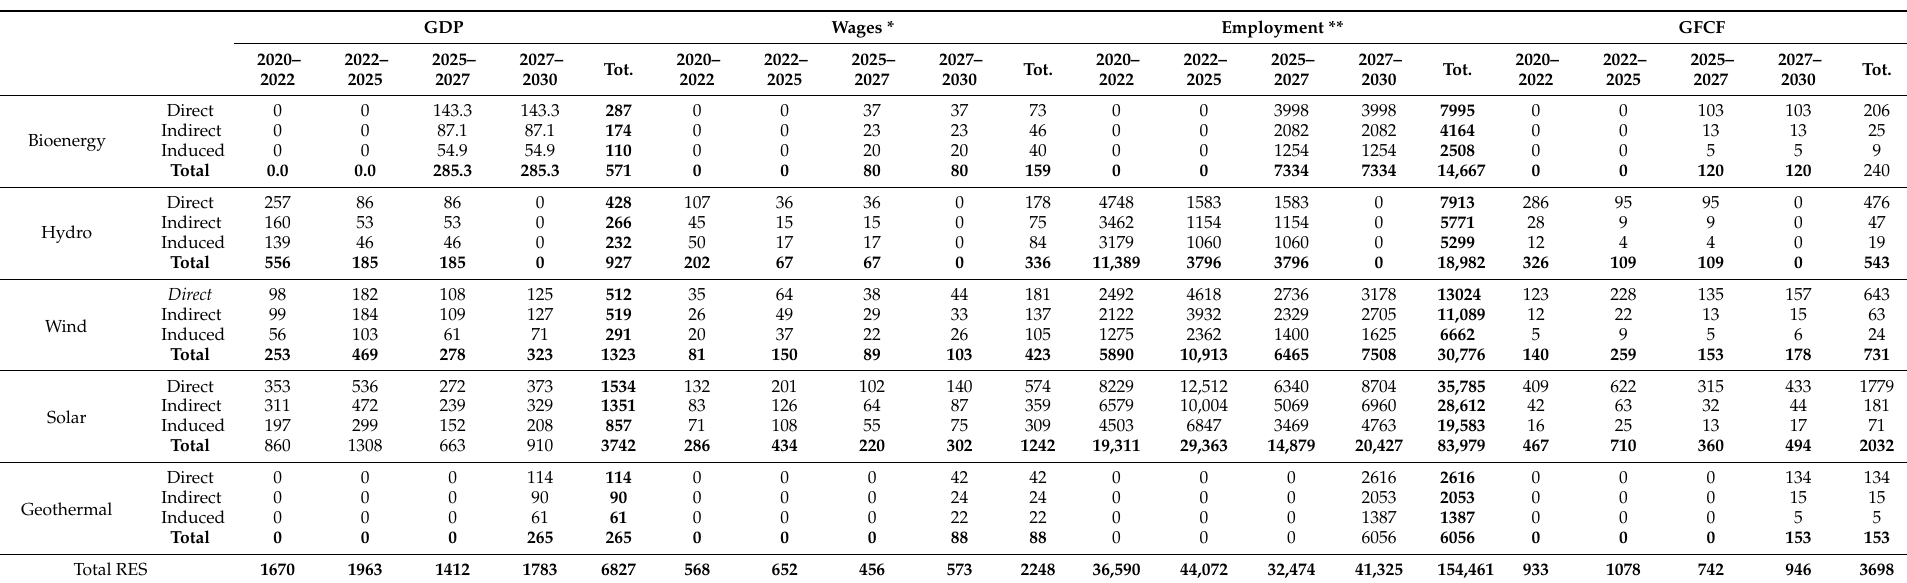
Table 8. Economic effects breakdown by energy type, time period, economic aspect of interest, and effect type (in mil €